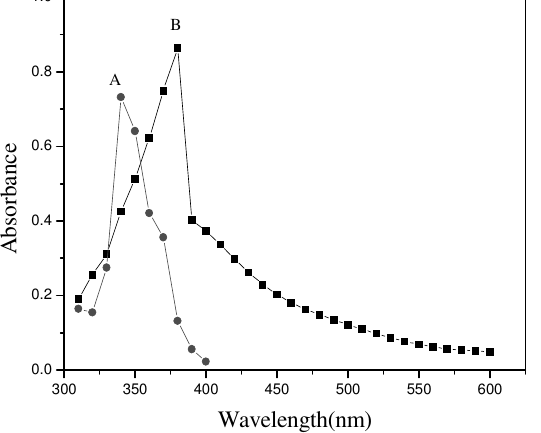
Figure 1 . Absorption spectra of (a) 3,4-DHBINH; (b) Pd(II)-3,4-DHBINH complex; Pd(II): 1 mL of 1.0×10 −4 M; 3,4-DHBINH: 1.0 mL of 1.0×10 −3 M ; pH: